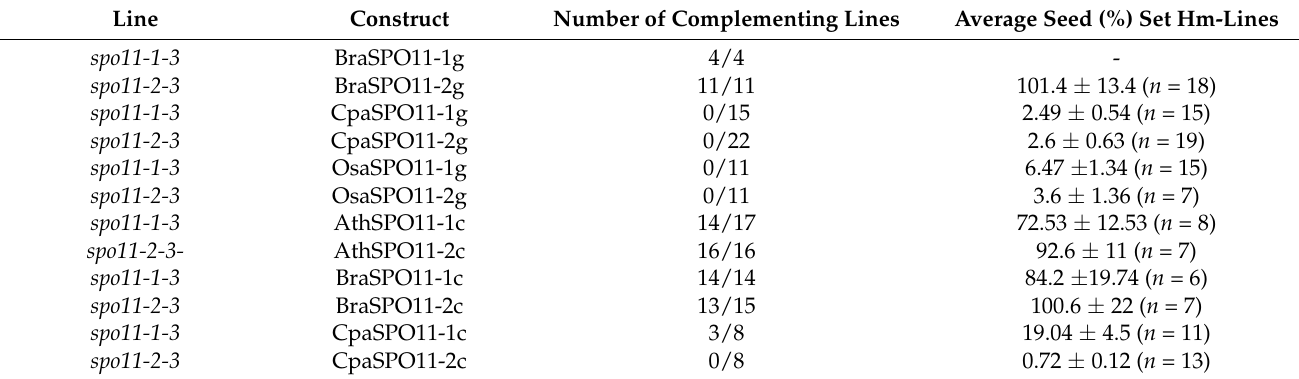
Table 3. Complementation of A. thaliana spo11-1-3 and spo11-2-3 with SPO11-1 or -2 from different plants.